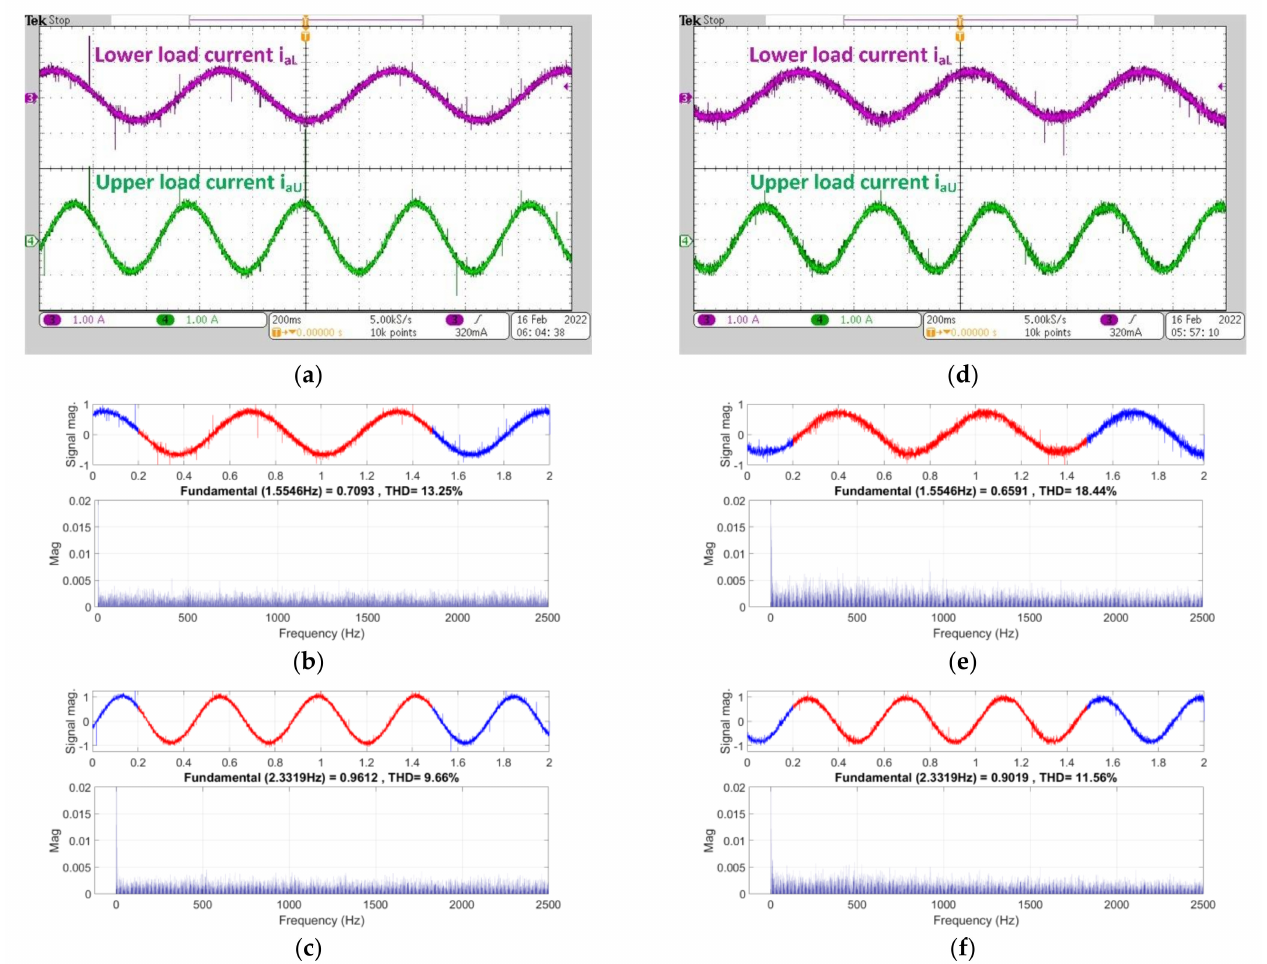
Figure 8. Comparison of the experimental current waveforms, THD results, and current spectrums for two control strategies: the left column is for the M 2 PC, the right column is for the FCS-MPC. ( a ) Experimental current waveforms for M 2 PC. ( b ) THD value and spectrum of the i aL for M 2 PC. ( c ) THD value and spectrum of the i aU for M 2 PC. ( d ) Experimental current waveforms for FCS-MPC. ( e ) THD value and spectrum of the i aL for FCS-MPC. ( f ) THD value and spectrum of the i aU for